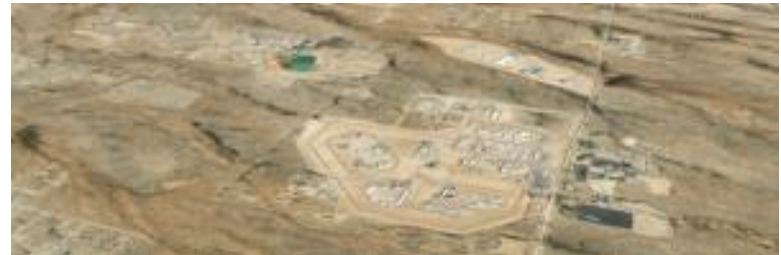
Figure 6. The spatial buffering and geographic isolation of Arizona State Prison, outside of Tuscon is characteristic of rural prison design today